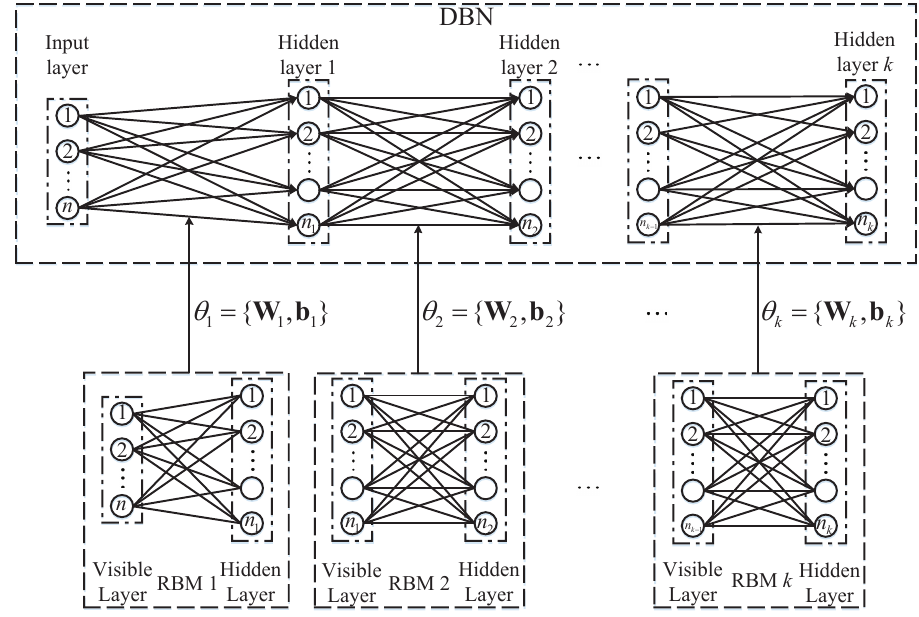
Figure 2. The architecture of the DBN with k hidden